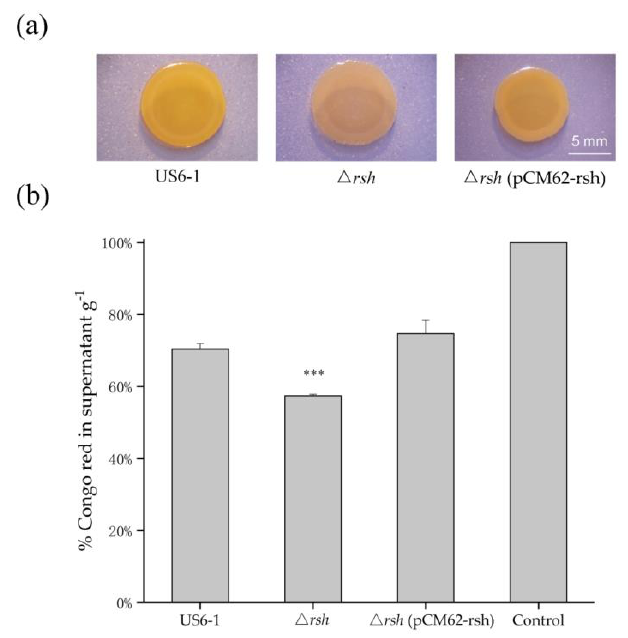
Figure 6. Assessment of EPS production of strain US6-1, ∆ rsh and ∆ rsh (pCM62-rsh). ( a ) Colony biofilm morphology of strains on the P5Y3 plates containing 40 µ g/mL Congo red. One representative experiment out of three independent biological replicates is shown. The white bar represents 5 mm. ( b ) Congo red binding assay. The biomass of strains grown in static culture for 96 h was determined gravimetrically as cell wet weigh. The bacterial mass was then mixed with 1 mL of Congo red (100 μg/mL) in 0.9% saline for binding. After removing the biomass, the OD 490 of unbound Congo red in supernatant was measured and the percentage of Congo red left in supernatant g − 1 was shown. The OD 490 of 100 μg/mL Congo red in 0.9% saline was used as the control. The results are averages of three replicates, and the error bars indicate standard deviations. “***” represents p < 0.001.